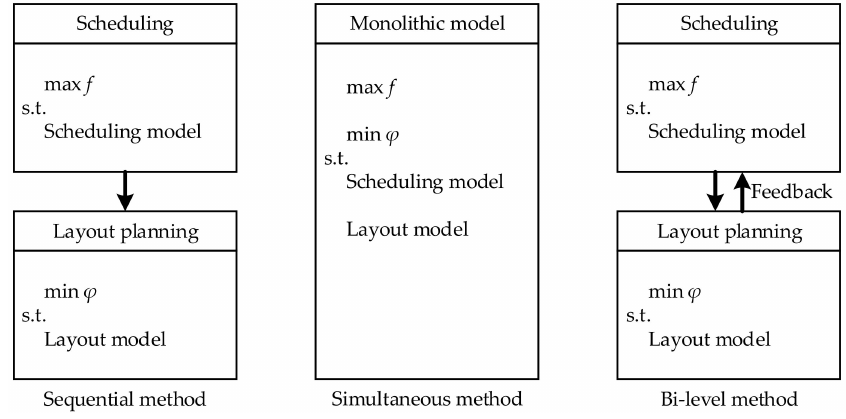
Figure 2. Structures of three methods for solving the ISLP